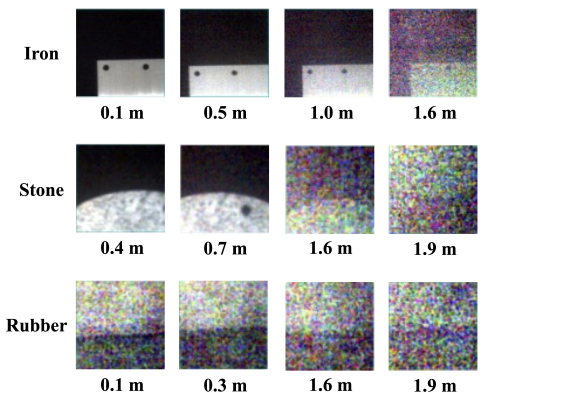
Figure 7. The selected dataset includes iron, stone and rubber at different